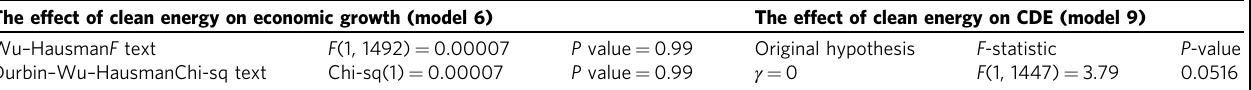
Table 1 Endogenous test: clean